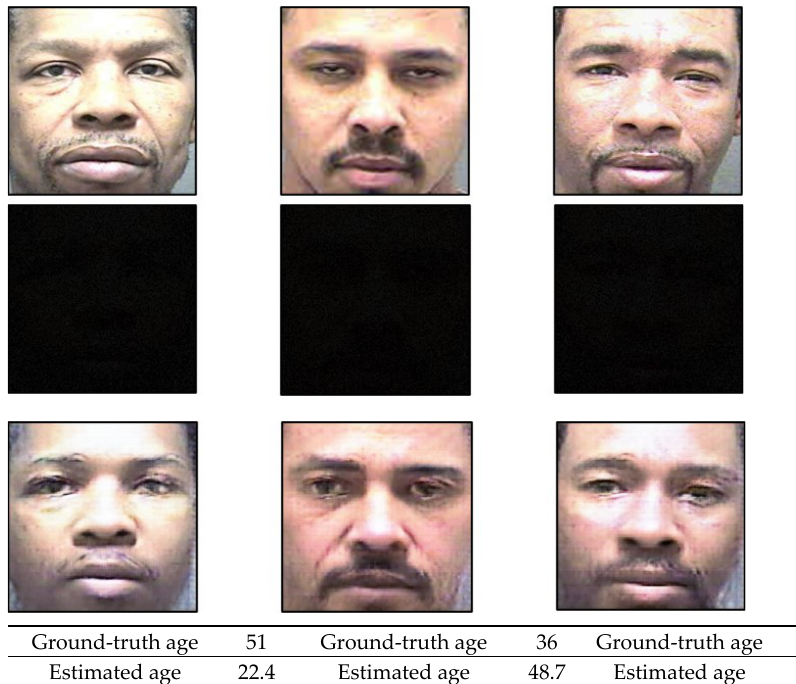
Figure 10. Bad cases of age estimation by the proposed method. The 1st, 2nd and 3rd rows show the original, low-illuminated images, and the images enhanced by LAE-GAN, respectively.